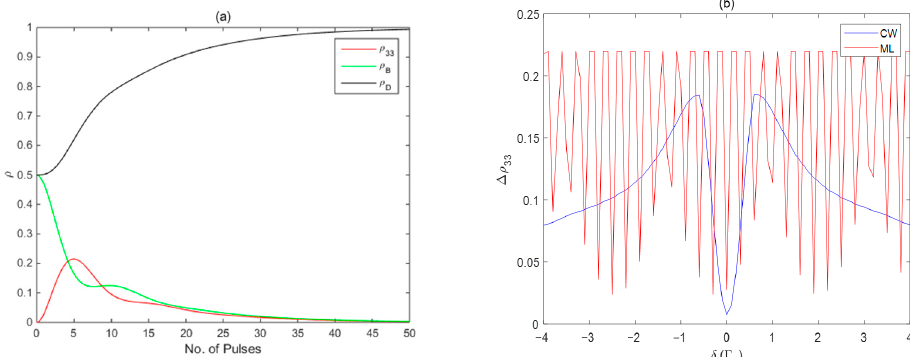
Figure 6. ( a ) The population of excited (red), bright (green) and dark (black) states change with the number of pulses. ( b )The excited state population change ( ∆ ρ 33 ) of the cold 87 Rb atoms varies with the Raman detuning ( δ ), and the Doppler shift is set to be δ D = 0.01 Γ 3 . The interrogating laser fields are cw (blue) and ML (red).